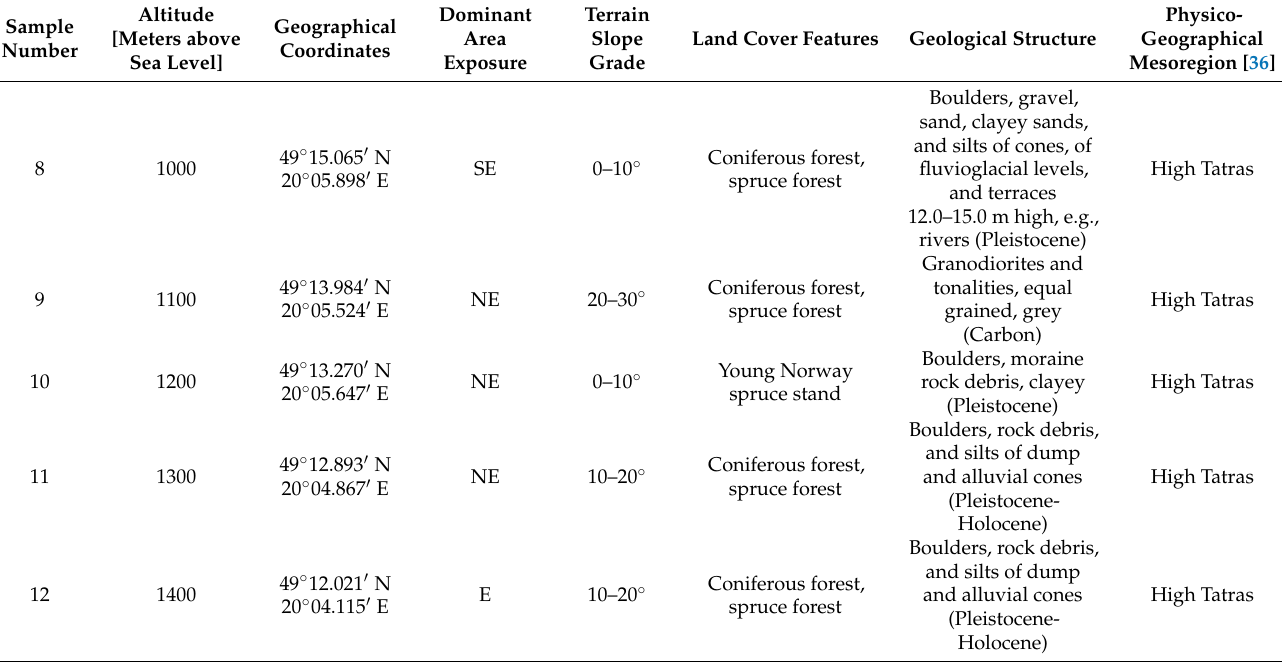
Table 2. Characteristics of sampling points of the Morskie Oko test area